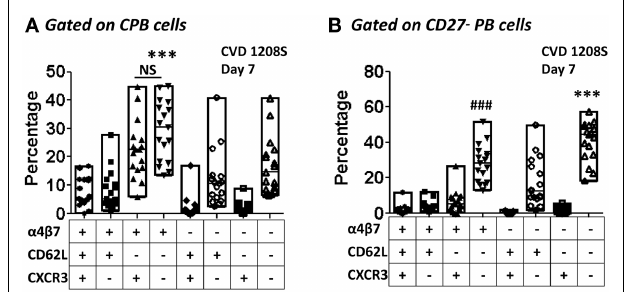
FIGURE 9 | Co-expression of homing molecules in CPB and CD27 − PB cells .The expression of integrin α 4 β 7, CD62L, and CXCR3 alone or in combinations (Boolean gates – FlowJo) were assayed in samples from day 7 in CPB and CD27 − PB gated cells [ (A,B) , respectively].The graph displays percentages of cells expressing each combination evaluated. Each symbol indicates an individual volunteer and in each group the bars indicate the highest and lowest percentages. Horizontal lines indicate the median.The groups were evaluated by one-way ANOVA, followed by Dunnet’s post-test using expression of integrin α 4 β 7 alone as the control group. (A) *** p < 0.0005 integrin α 4 β 7 alone versus all other groups except for integrin α 4 β 7 + CXCR3 + . NS; not significant. (B) ### p < 0.0005 integrin α 4 β 7 alone versus all other groups, except integrin α 4 β 7 − CD62L − CXCR3 − , *** p < 0.0005 integrin α 4 β 7 − CD62L − CXCR3 − versus all other